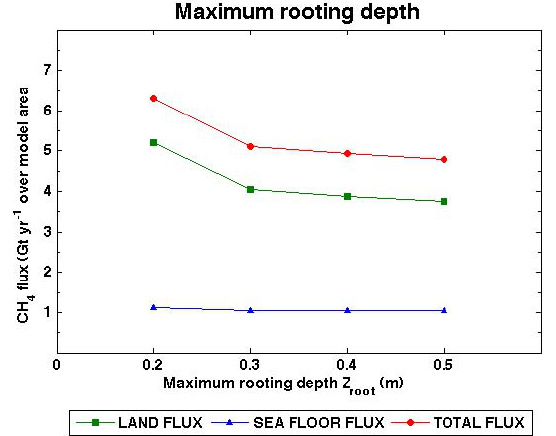
Fig. 4. Increasing the maximum depth of the vegetation root system results in a nonlinear decrease of the CH 4 fluxes.